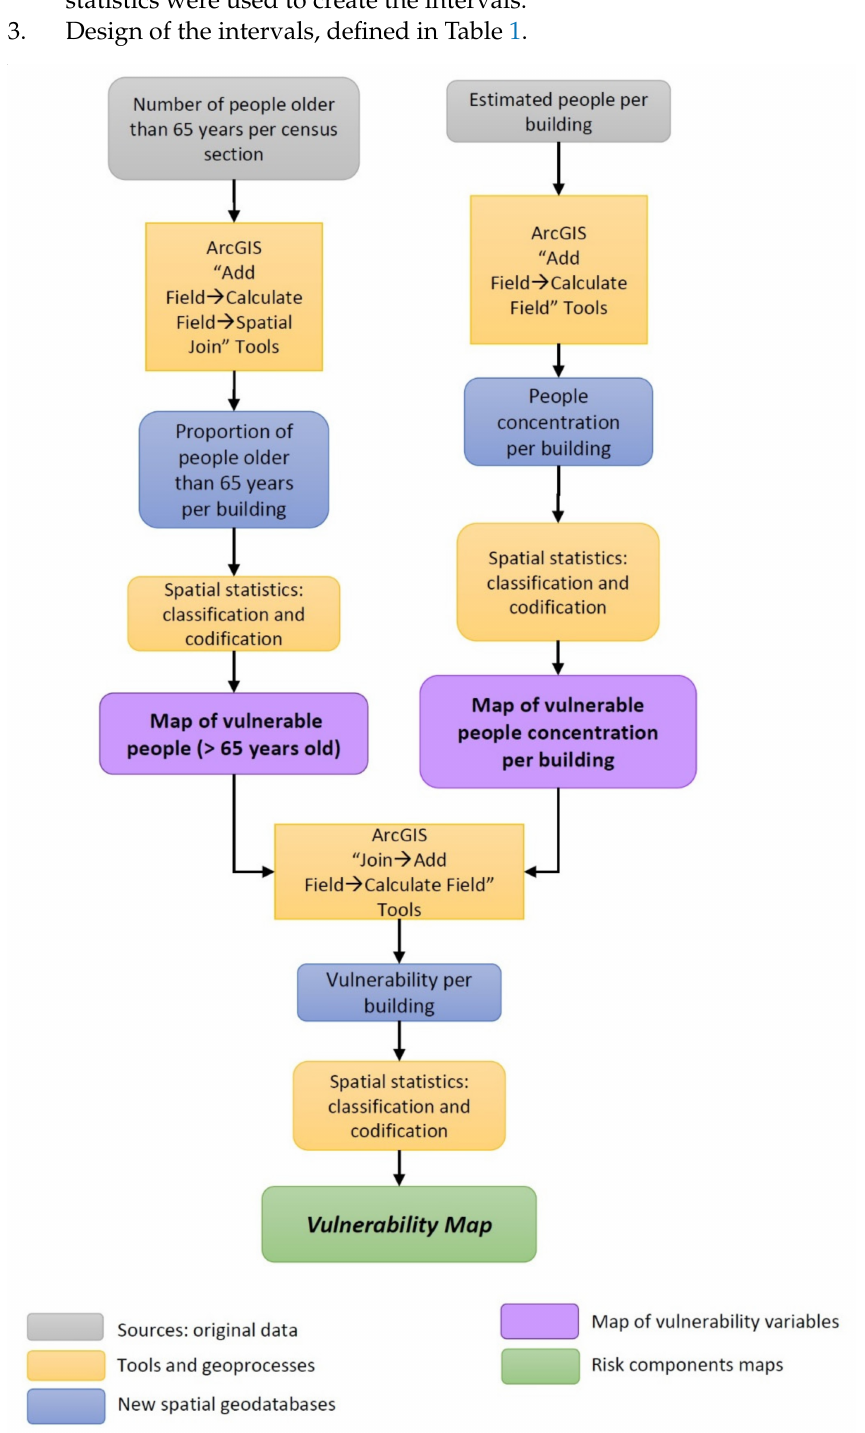
Figure 3. Flowchart of the vulnerability map. Own